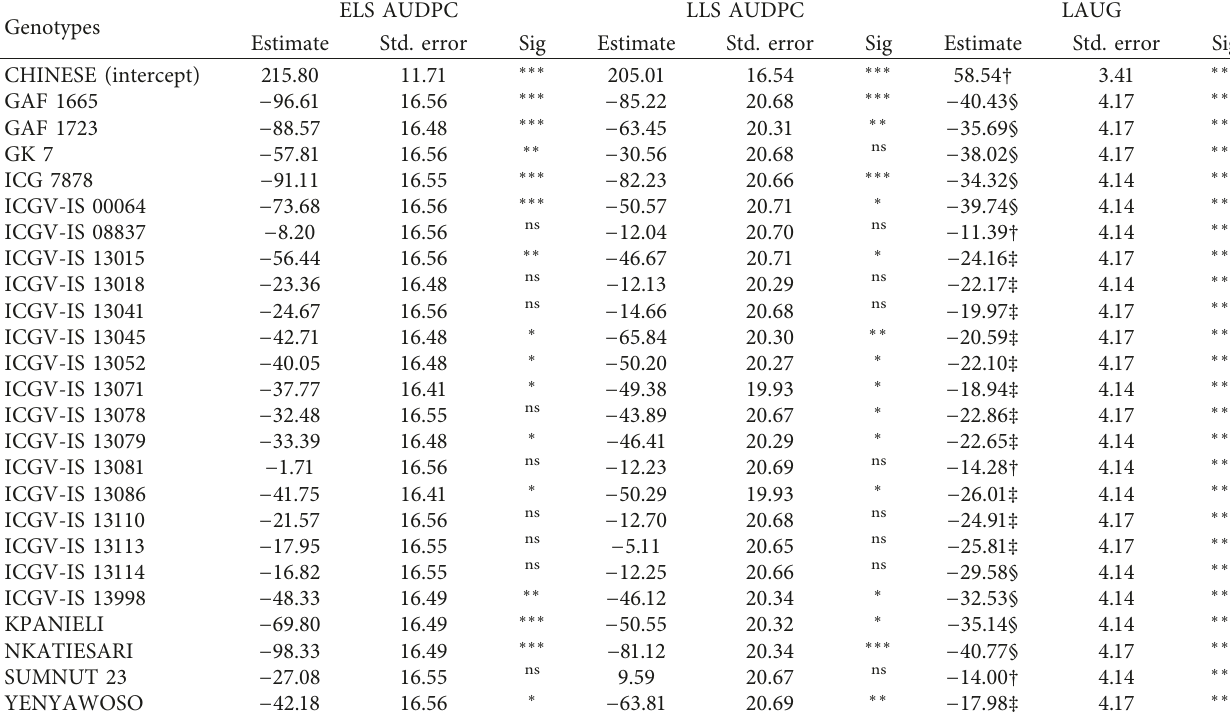
Table 3: Area under disease progress curve for early leaf spot (ELS AUDPC) and late leaf spot (LLS AUDPC) diseases and leaf area under greenness (LAUG) of 25 groundnut genotypes evaluated under disease and disease-free conditions in 2017.